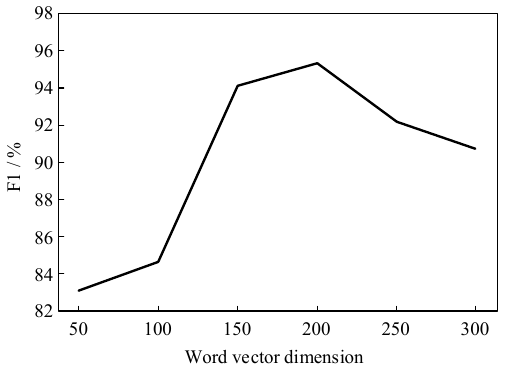
Figure 4. Influence of WV dimension on F1.